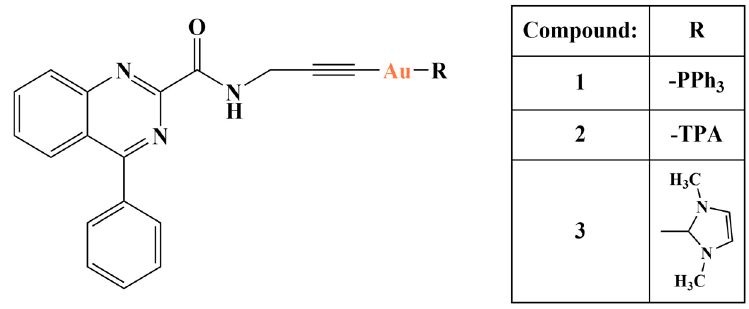
Figure 32. Some of the complexes presented in